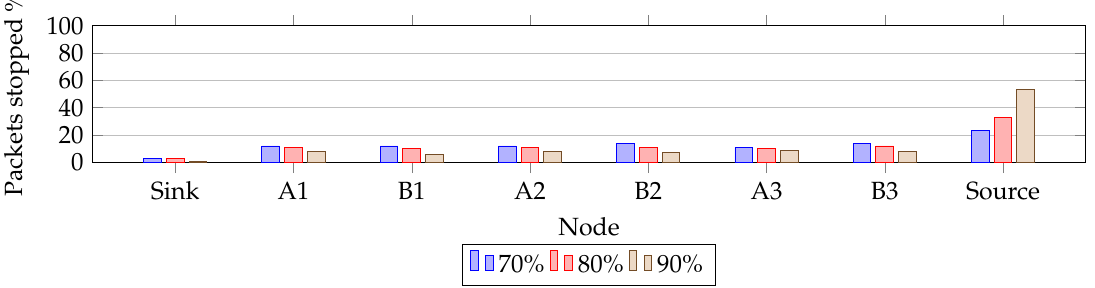
Figure 10. Packet elimination distribution for τ =